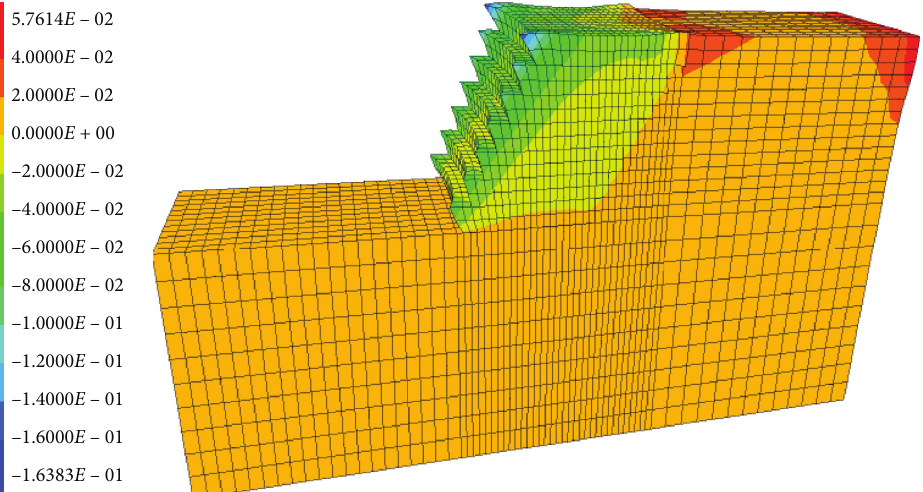
Figure 6: Displacement of the unreinforced retaining wall at 18.4s.